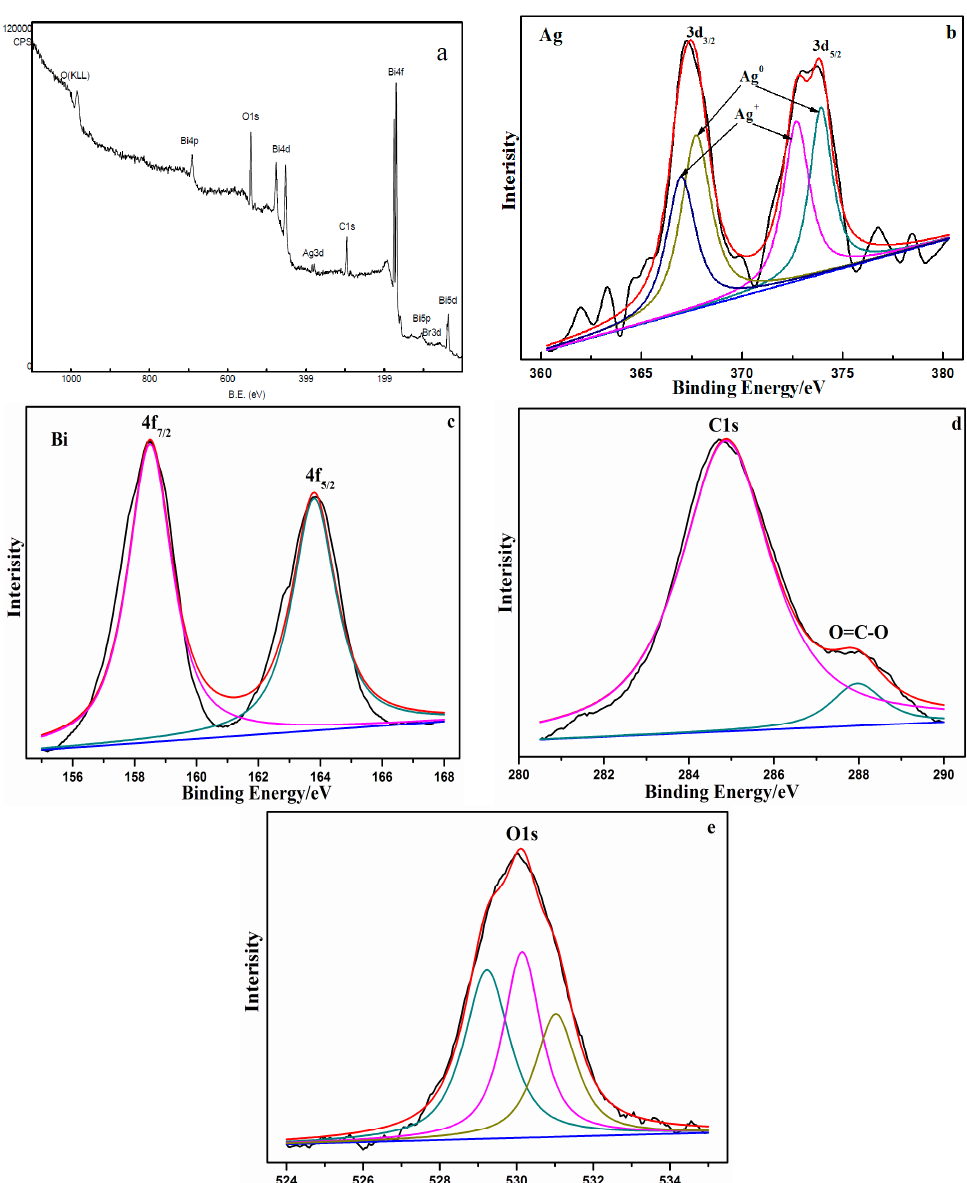
Figure 5. ( a ) XPS survey spectrum of Ag@AgBr(7 wt %)/Bi 2 O 2 CO 3 . High resolution XPS spectra of: ( b